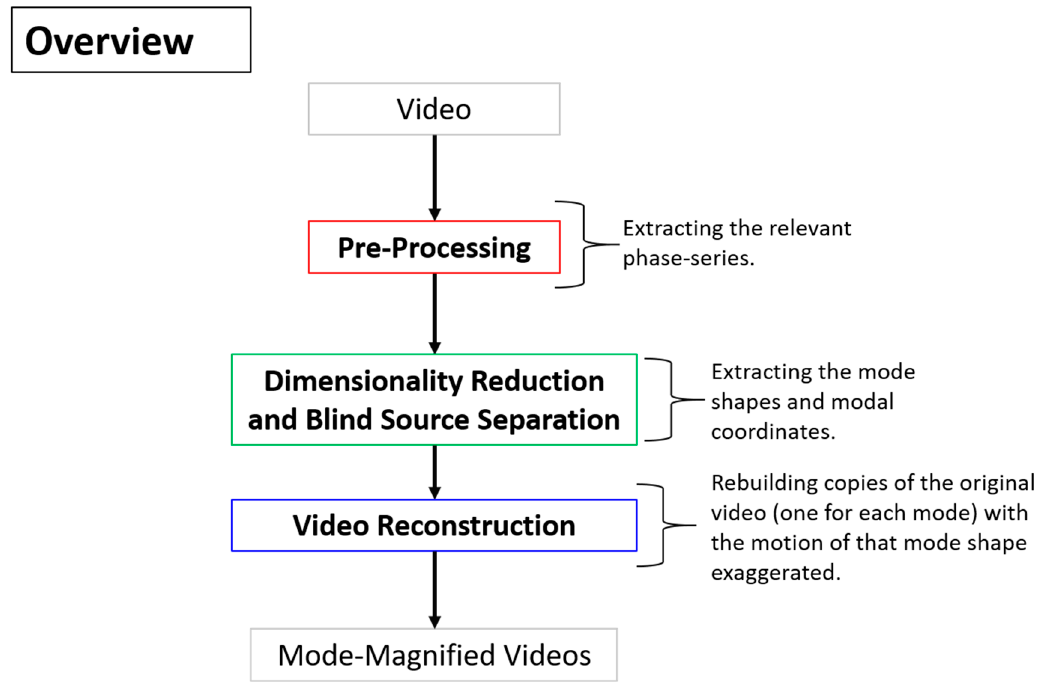
Figure 2. Color-coded overview of the main steps in the video dynamics algorithm.